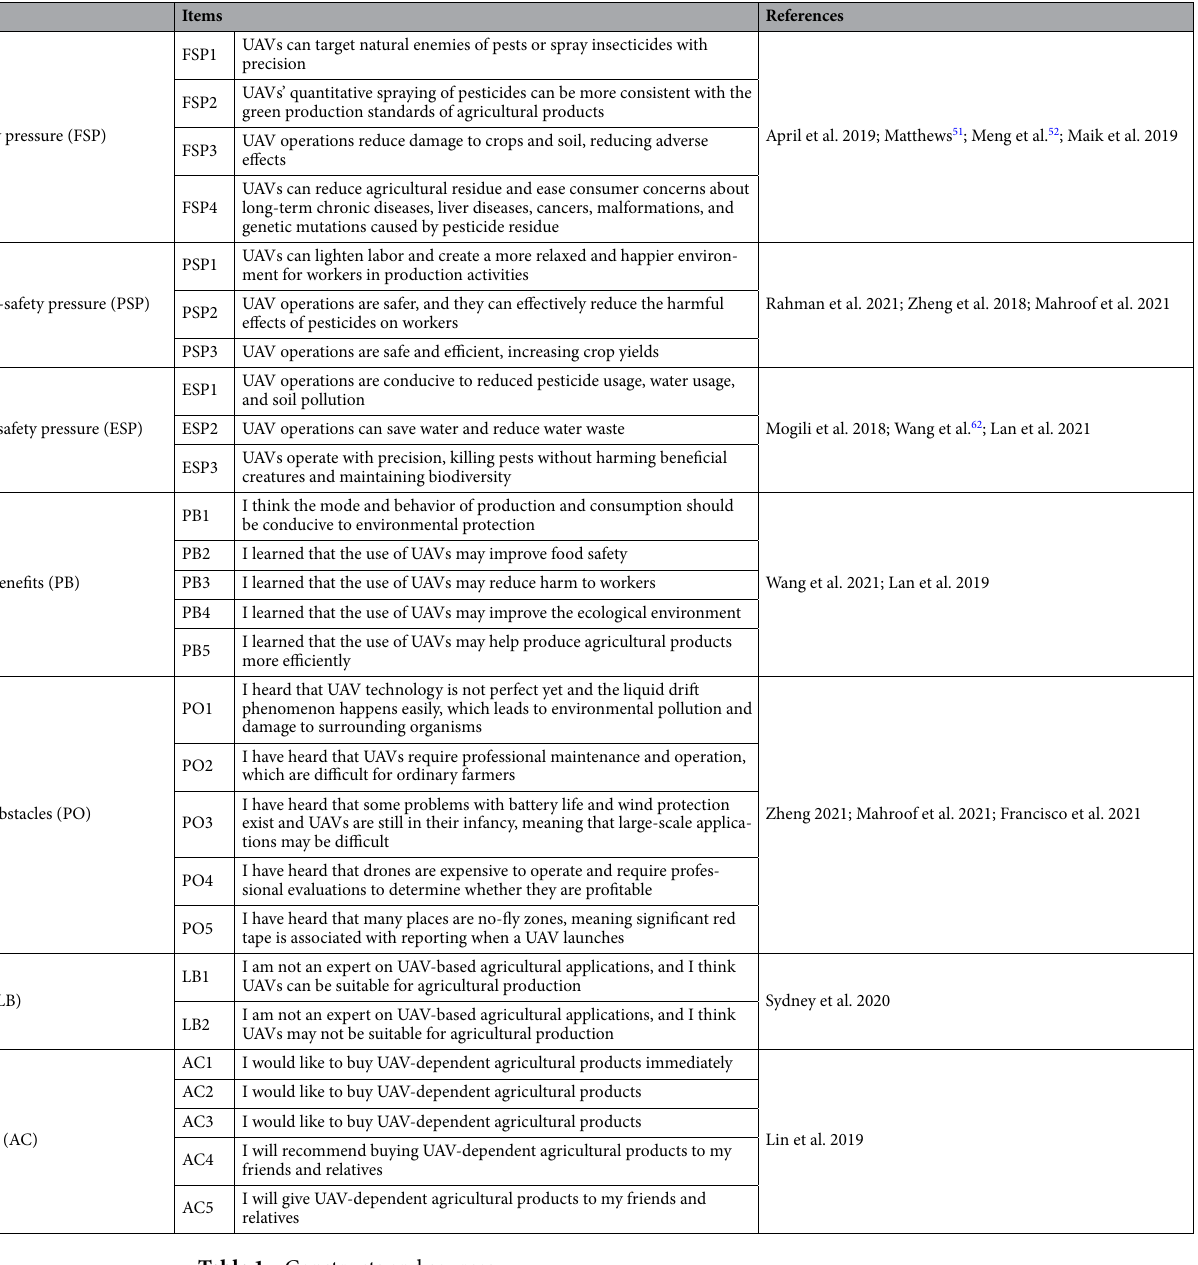
Table 1. Constructs and